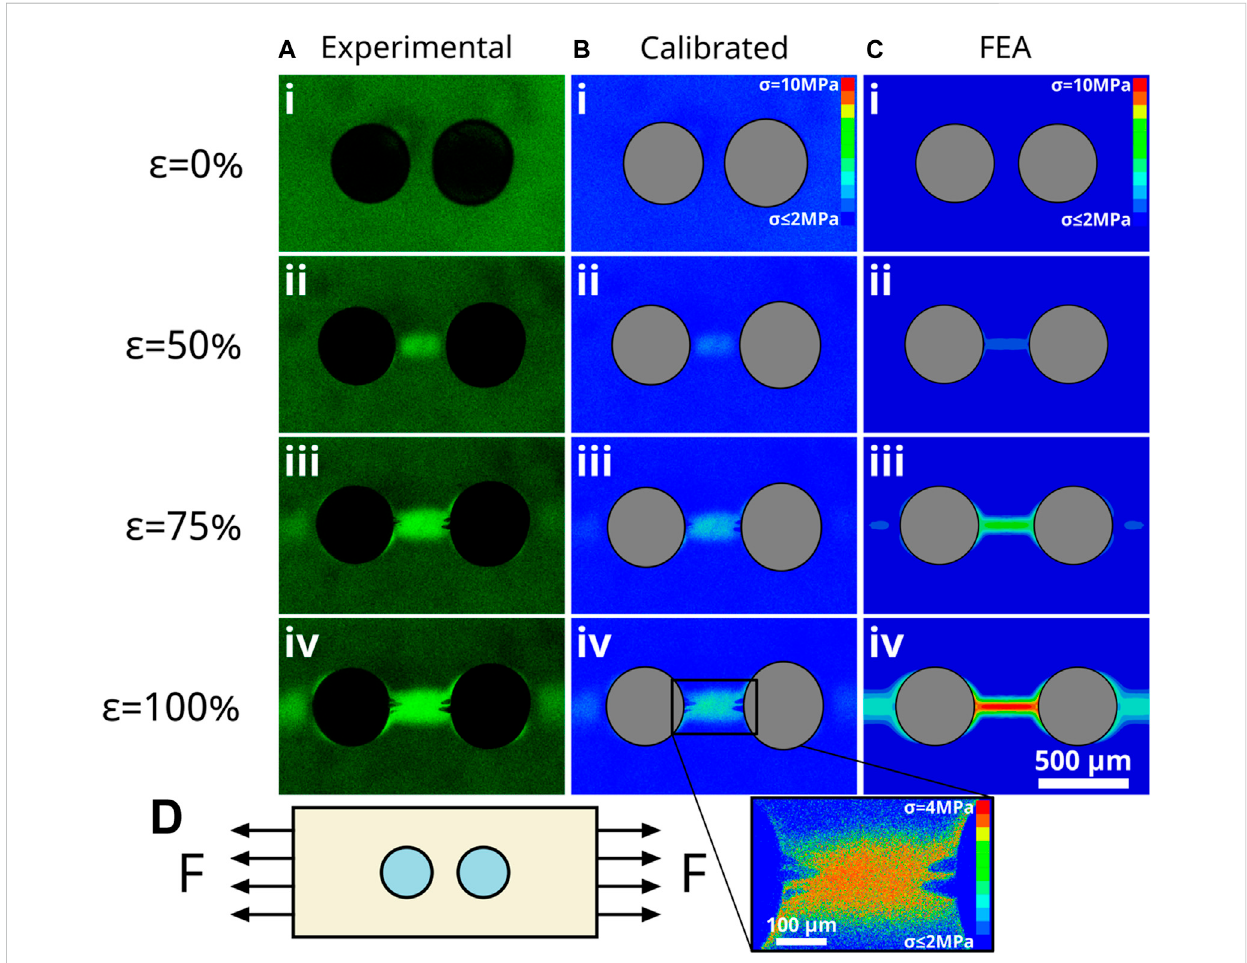
Demonstration of MP calibration for two-particle system. (A) In situ fl uorescence images obtained for a two-particle composite deformed from 0% to 100% strain as indicated on the left. (B) Corresponding calibrated stress images utilizing calibration determined from single-particle experiments. (C) FEA model of a two-particle system. Scale bar in C.iv applies to all images. (D) Schematic representation of loading